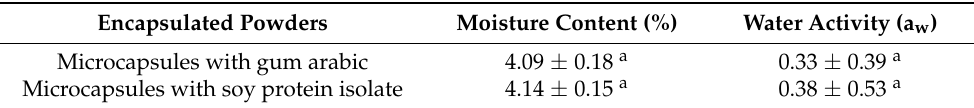
Table 2. Moisture content (%) and water activity (a w ) of microcapsules with gum arabic and soy protein